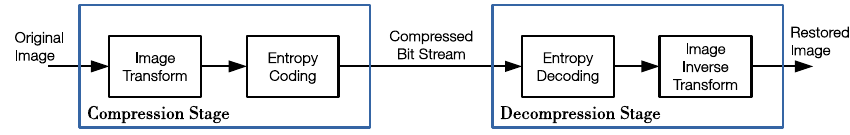
Figure 3. A typical procedure showing the compression and decompression stages.